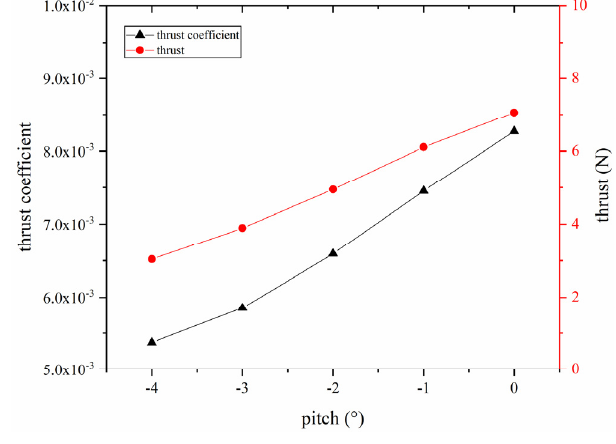
Figure 20. The thrust and thrust coefficient change with 𝜃.